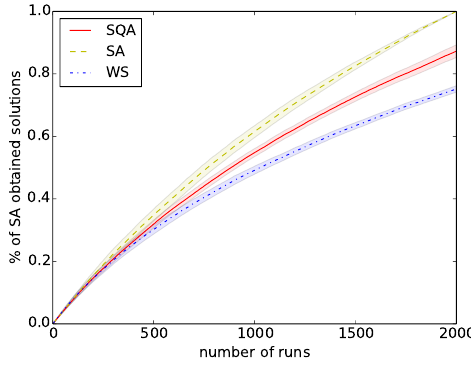
Figure 1: Average number of different solutions obtained, when running each solver 2000 times on each instance. The average is taken over 20 randomly generated 4-SAT instances with n = 50 variables and a clauses-to-variables-ratio of α χ solutions obtained is normalized by the maximum number of different solutions found by SA within 2000 runs (about